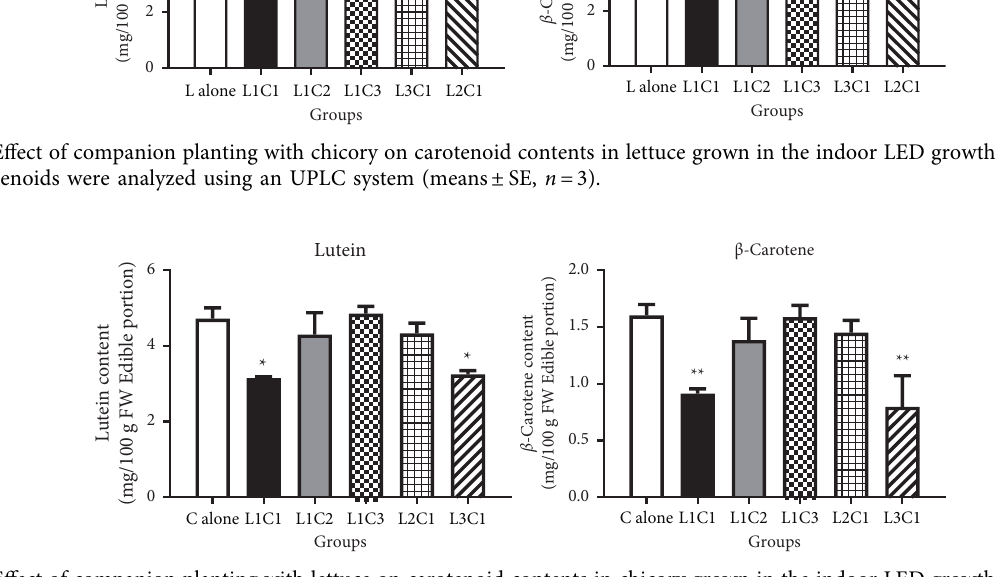
Figure 7: Effect of companion planting with lettuce on carotenoid contents in chicory grown in the indoor LED growth chamber for 25 days. Carotenoids were analyzed using an UPLC system (means ± SE, n �